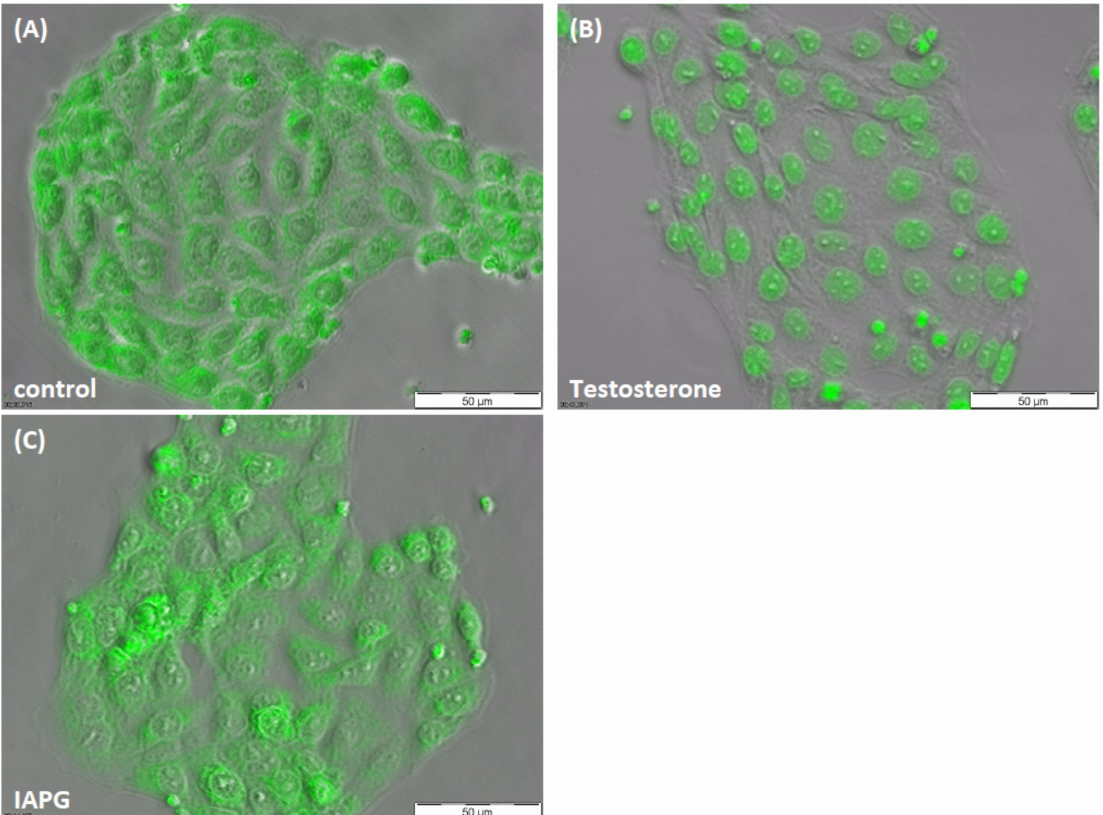
Figure 3. Immunofluorescence of AR in PASC1 cells. Cells were treated with testosterone or IAPG for 2 h. ( A ) AR (green) was distributed in the cytoplasm and in the nucleus in the untreated control. ( B ) After exposure to 10 nM testosterone, AR translocated into the nuclei. ( C ) There was no change in AR localization with 10 µ M